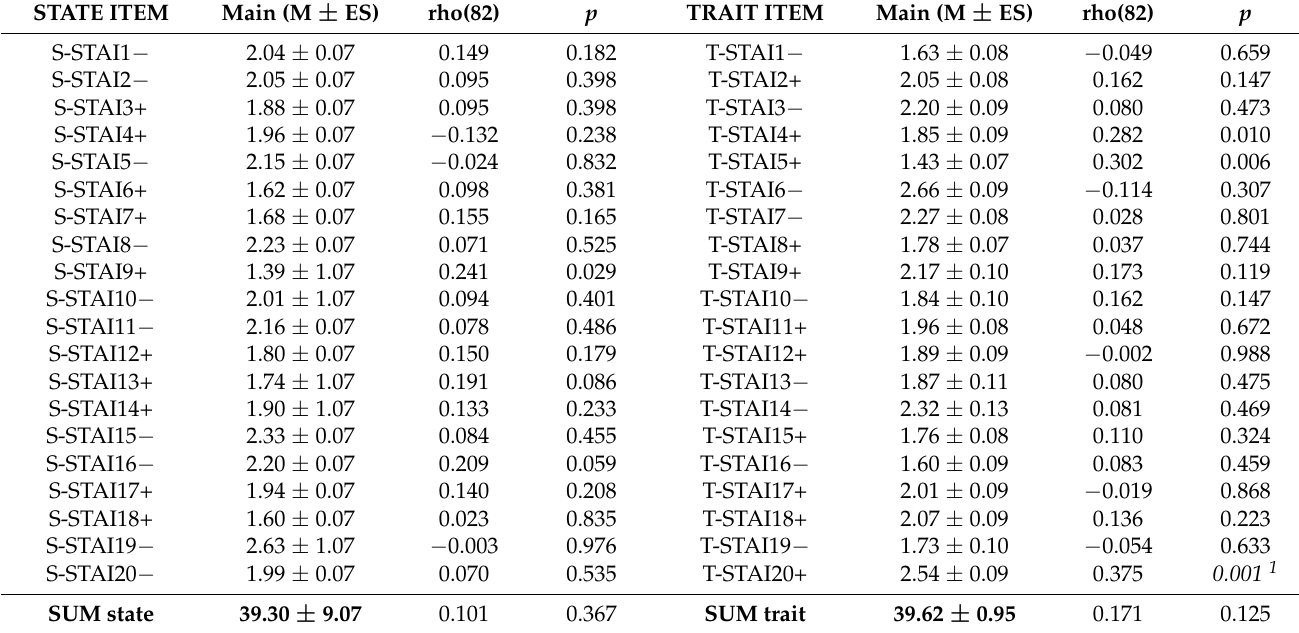
Table 4. Spearman’s correlation between STAI items and the difference between NoMask and Mask conditions in the main experiment. Multiple comparisons’ significant threshold levels were adjusted with Bonferroni correction (0.05/20 items, p =